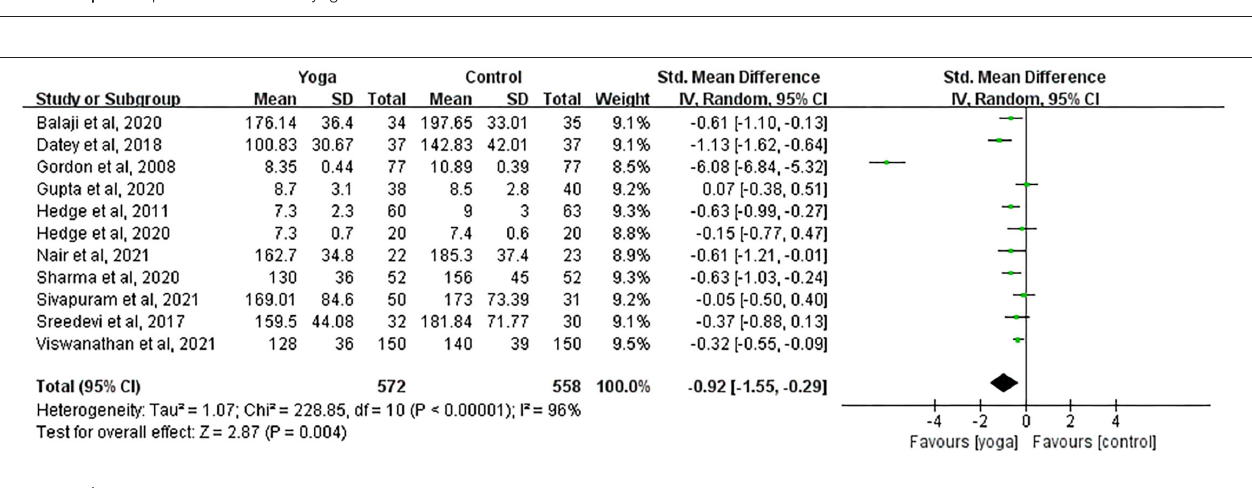
FIGURE 5 | Forest plots of the effect of yoga on FBG.